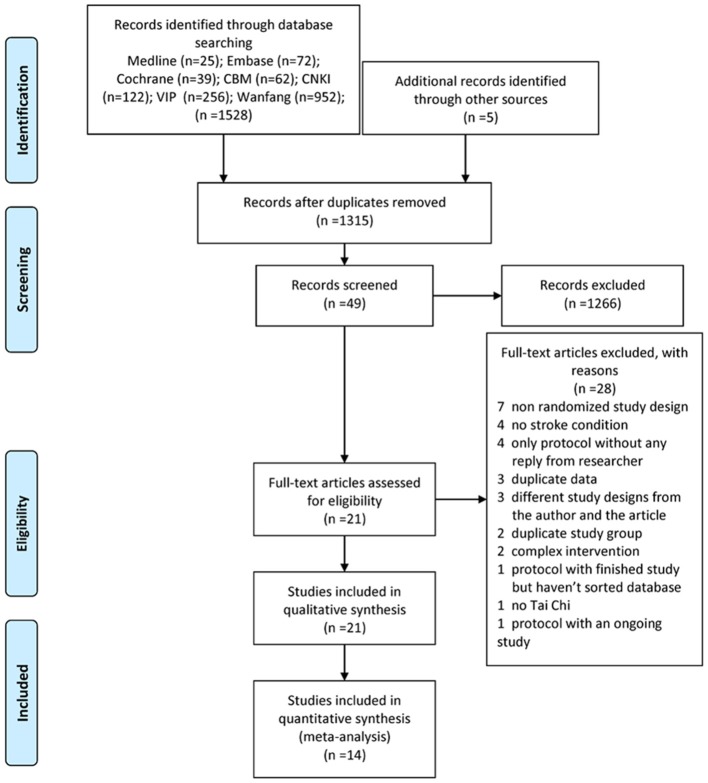
PRISMA 2009 flow diagram.